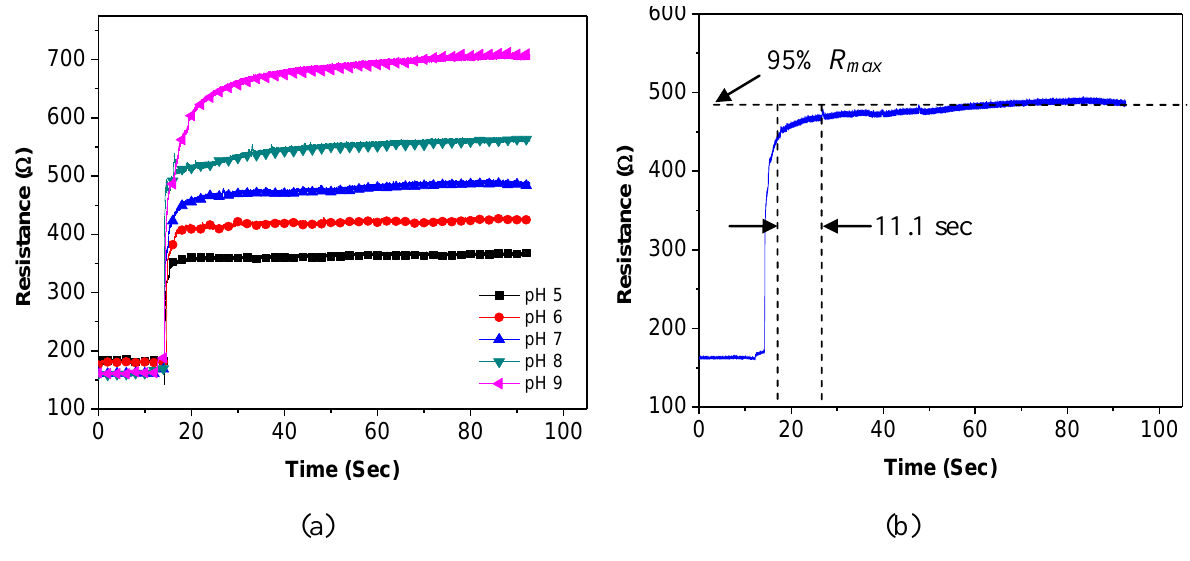
Figure 8. (a) pH response under buffer solutions from pH-5 to pH-9. (b) The response time of the sensor under the pH-7 buffer solution.